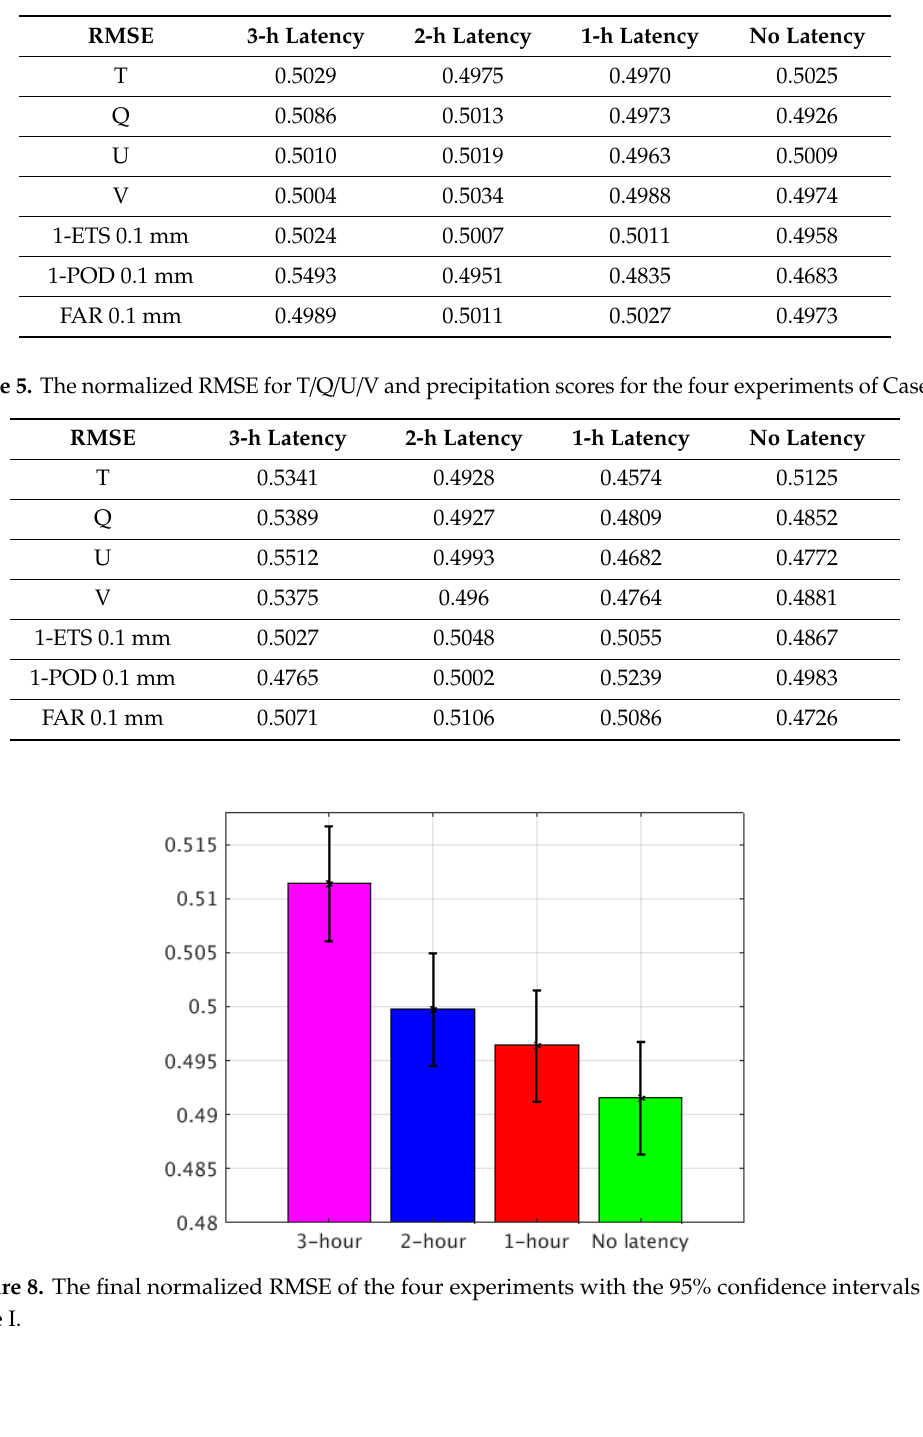
Figure 9. The final normalized RMSE of the four experiments with the 95% confidence intervals for Case II. 5. Summary The forecast of LSS and other rapidly changing weather events depends on how frequently and quickly the forecasts are updated. The low latency sounder data from satellites are very important in improving the pre-convection atmospheric conditions in NWP based, short-range forecasts. Such low latency data from polar orbiting satellites are available from direct broadcast (DB) sites, while the low latency data from geostationary satellites are available from GRB. In this study, the impact of low latency from sounders onboard polar orbiting satellites were demonstrated. Our findings indicate that (1) data latency directly affects the amount of data that can be assimilated into an NWP system and for data coverage, almost all types of satellite observations are increased from 3-hour latency to no latency; (2) low latency from polar orbiting satellites results in better forecasts for precipitation and forecast fields (T/Q/U/V) of 1-hour latency and no latency are much closer to the observations, and these low latency LEO data can be obtained via DB sites; and (3) the final normalized RMSEs of T/Q/U/V/1-ETS/1-POD/FAR indicate the following order in terms of better impact: no latency > 1-